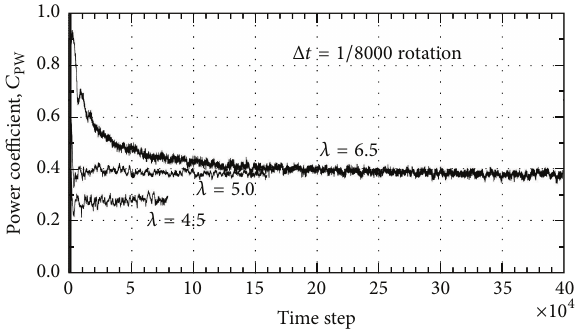
Figure 6: Time history of power coefficients.